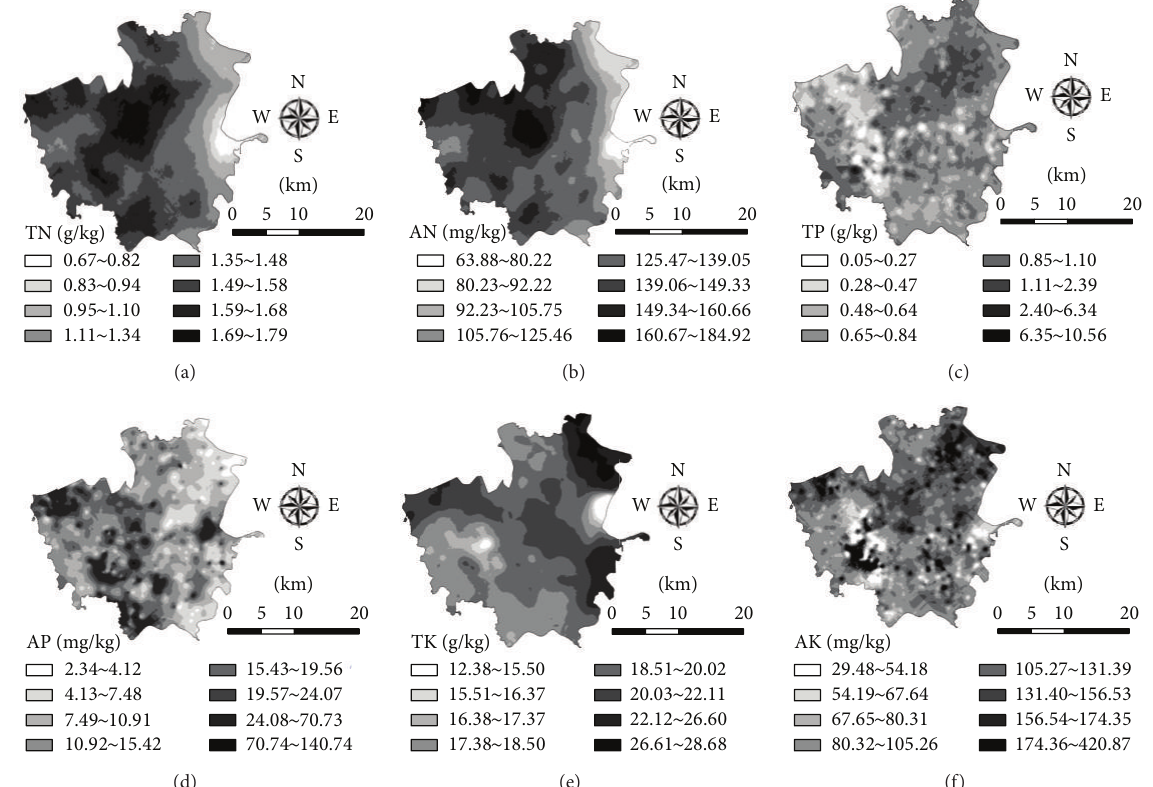
Figure 4: Spatial distribution maps of TN (a), AN (b), TP (c), AP (d), TK (e), and AK (f), interpolated by ordinary kriging.